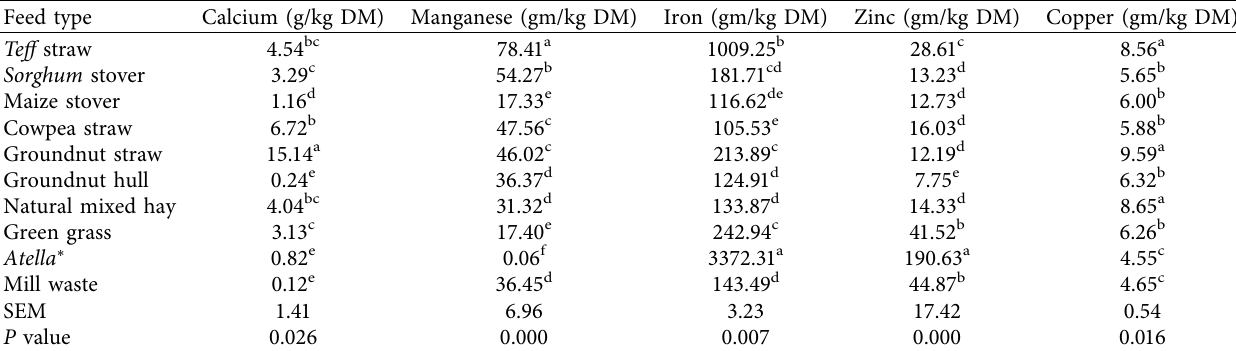
Table 4: Macro- and micromineral profile of major feed